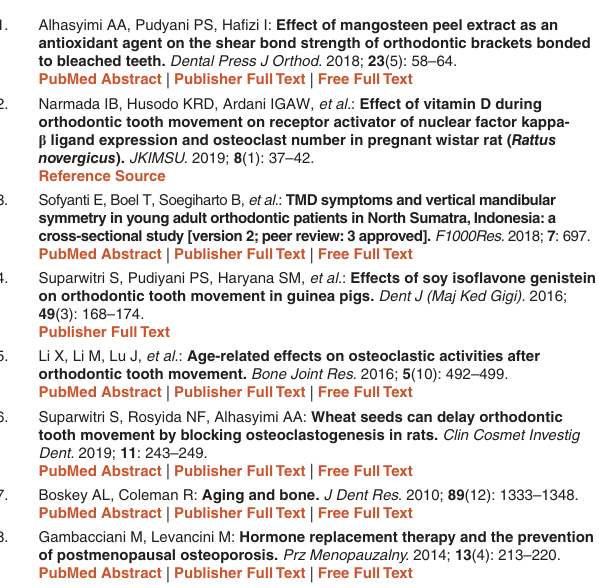
Figshare: OUTPUT Statistic Isoflavon TGF.docx. https://doi. org/10.6084/m9.figshare.10117340 29